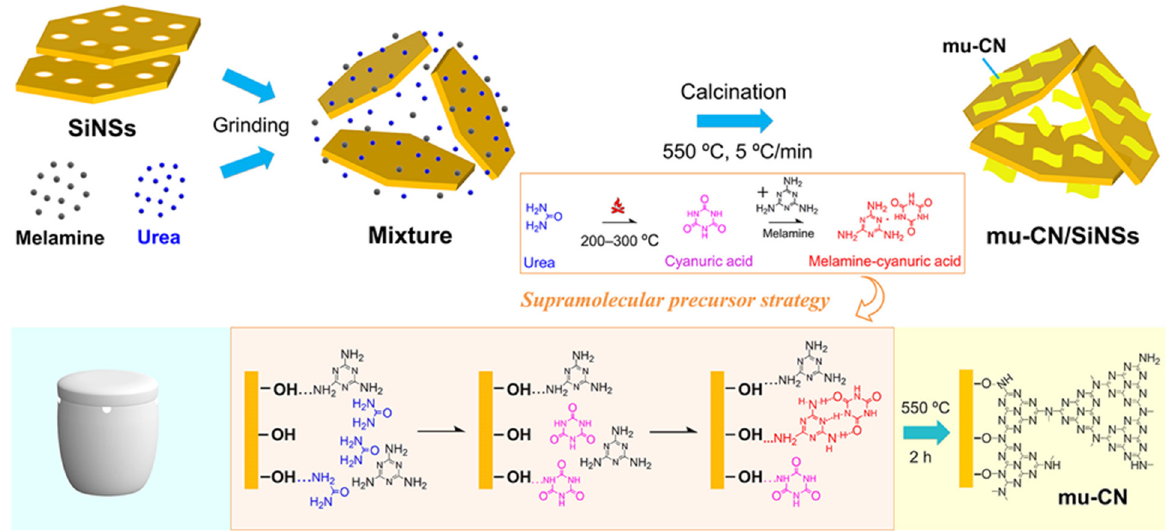
Figure 1. Schematic illustration of the mu-CN/SiNSs composite